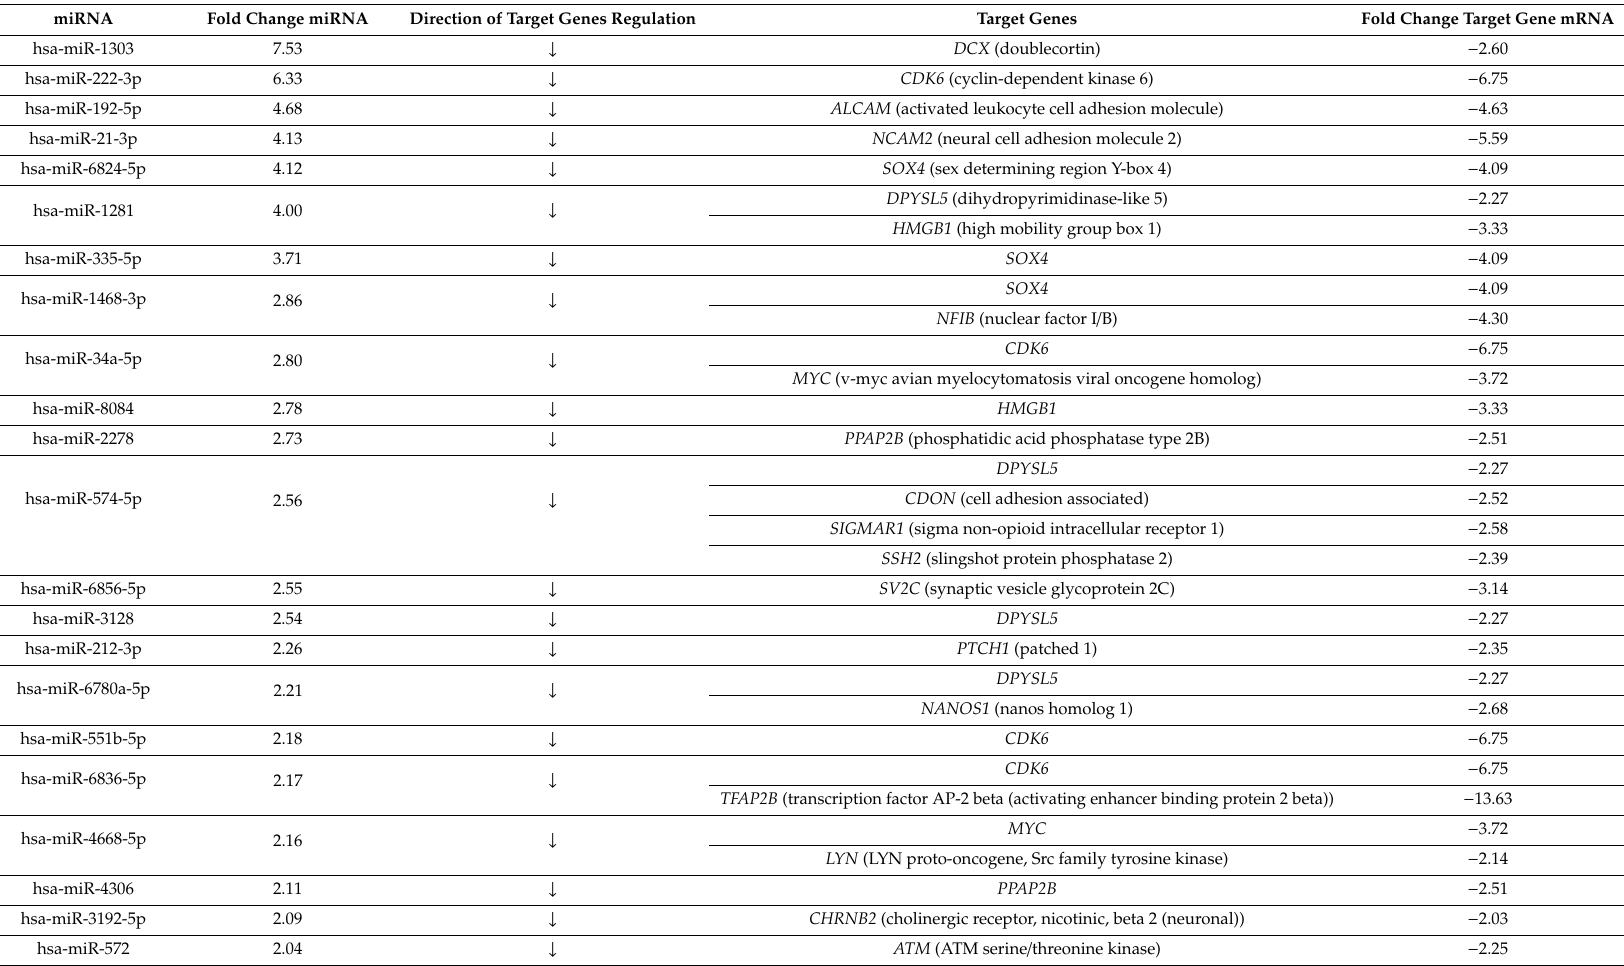
Table 6. The list of most dysregulated miRNAs with their targets, which are involved in neurogenesis, in bortezomib-treated SH-SY5Y cells compared to controls. Presented miRNAs downregulate expression of their target genes, hence the direction of target genes regulation is marked as “ ↓ ” and the fold change of target gene is always negative, indicating decreased